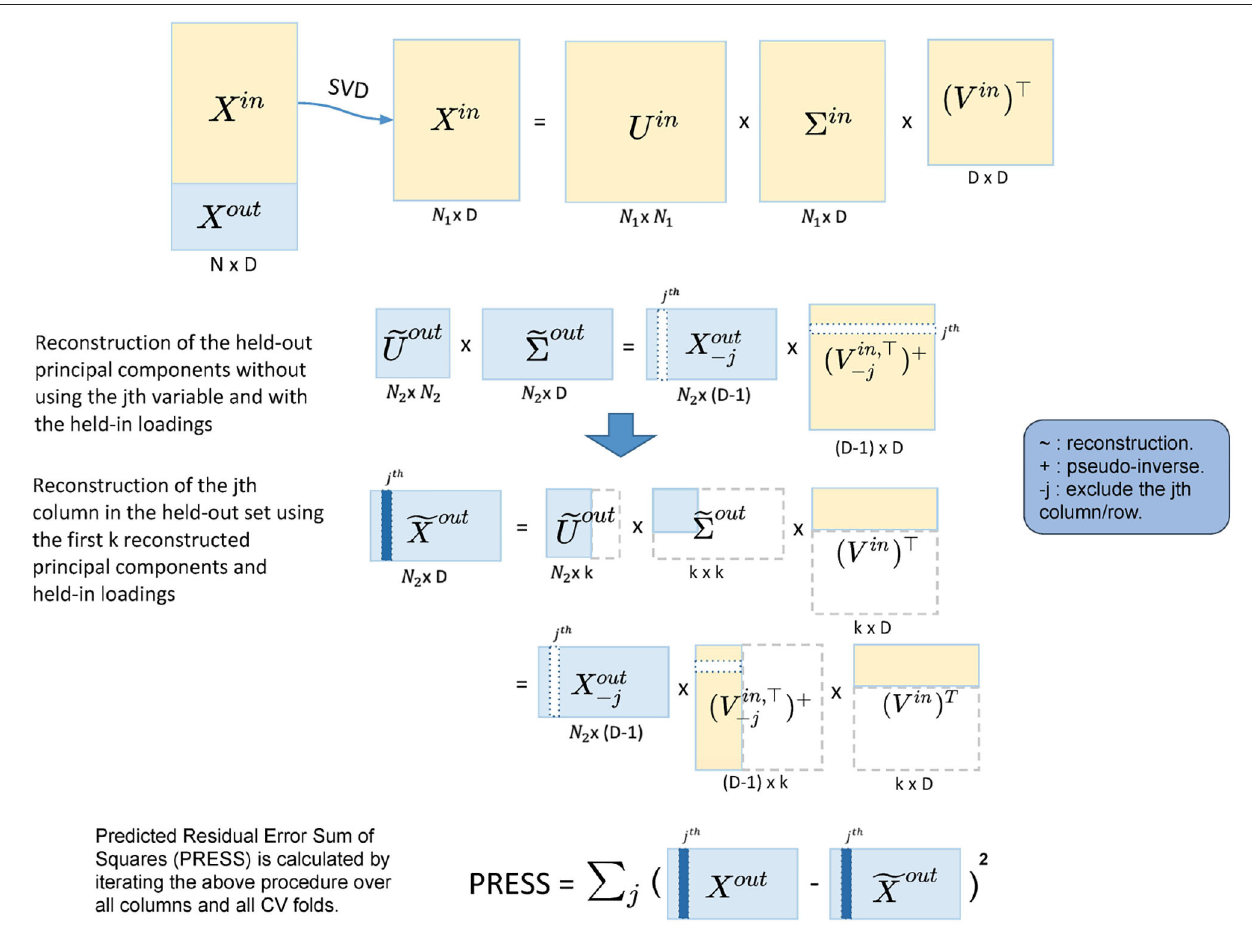
FIGURE 2 | Illustration of the five-fold two-way cross-validation (CV). It minimizes PRESS and estimates the dimensionality in an automated fashion. Yellow blocks represent the training data and light blue blocks represent the test data. A two-way CV includes a subject-way (CV over subject direction) and a variable-way (CV over variable direction). The prediction error is calculated by the reconstruction error using different numbers of principal